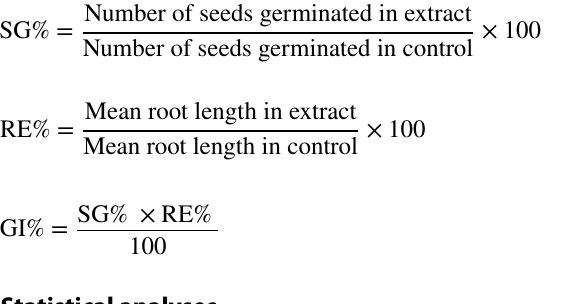
Table 1 Initial chemical characteristics of the straw residues, finger millet straw (FMS), sorghum straw (SS) and soybean (SB) straw and saw dust (SD)